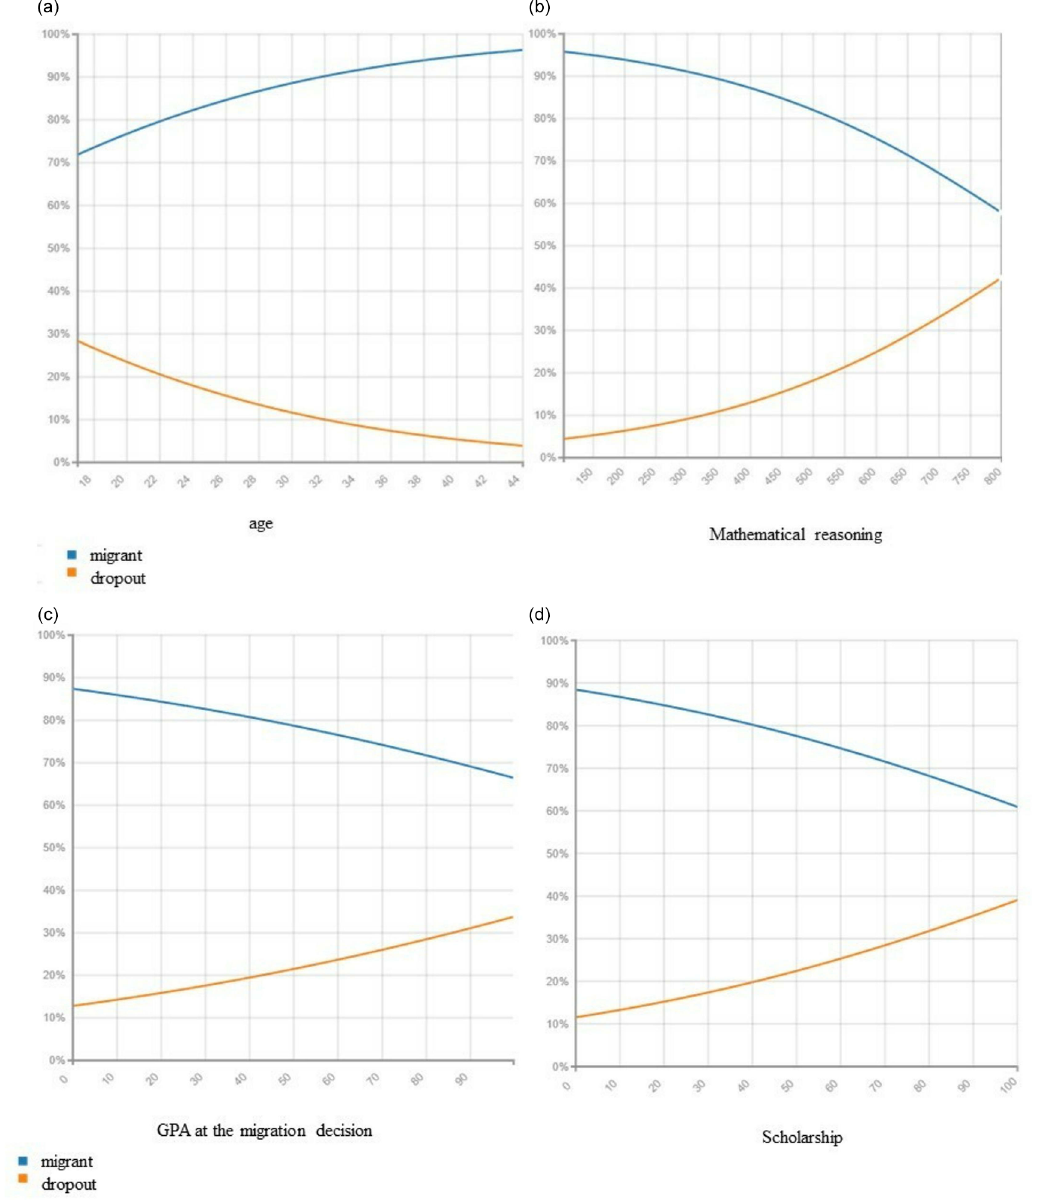
Figure 4. Migration probability given a. Dropout rate, b. Mathematical reasoning results, c. GPA at the migration decision and d. Having a